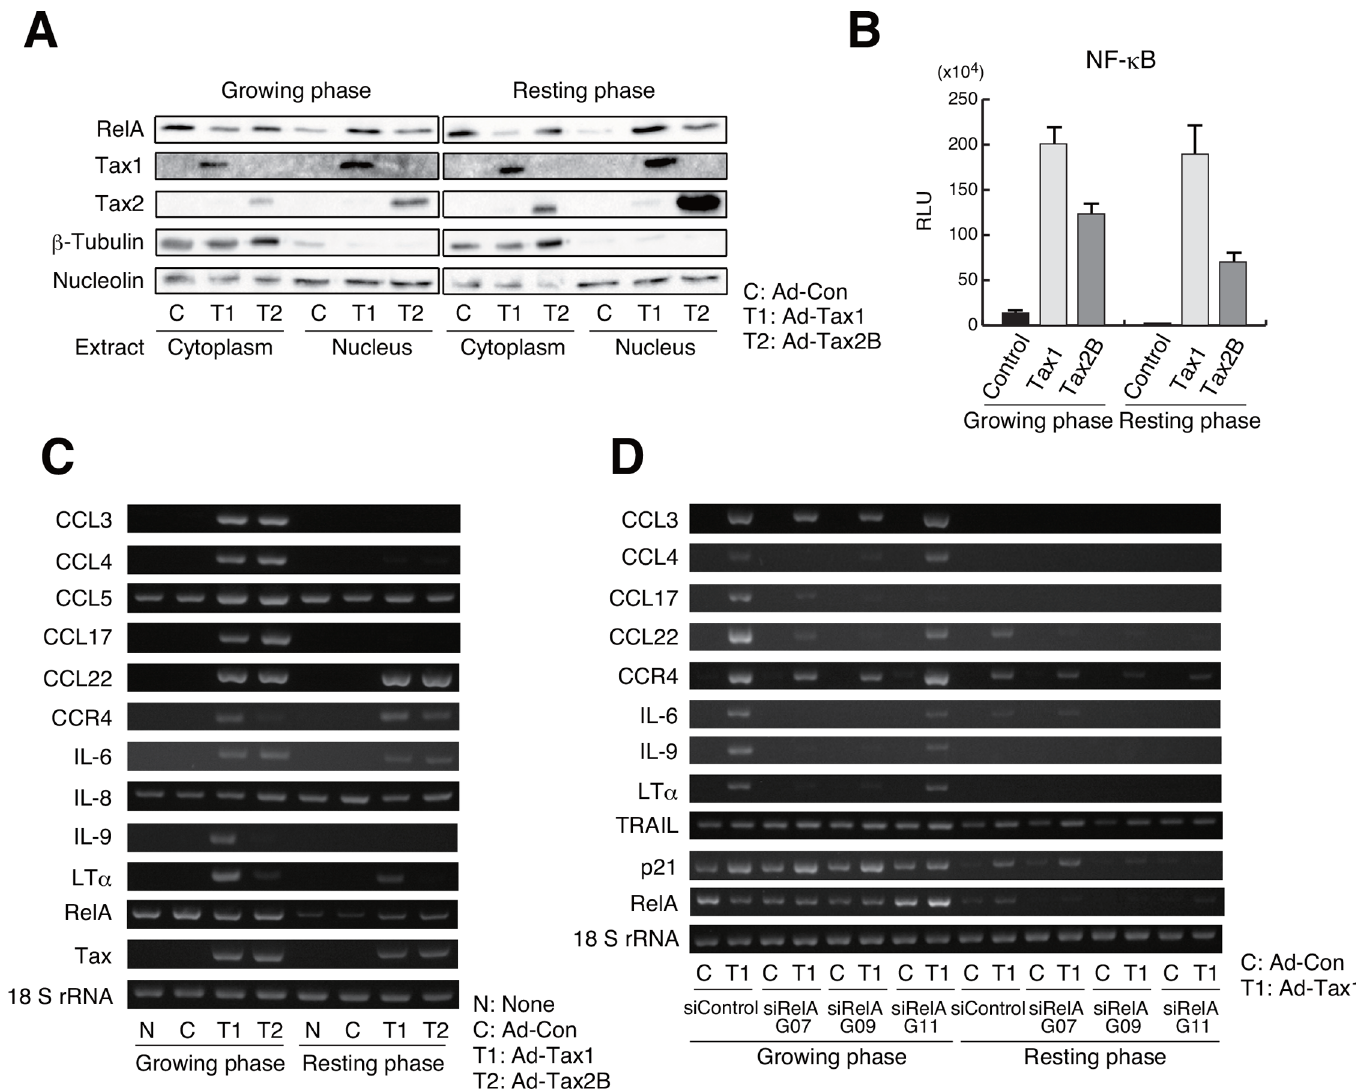
Fig 9. Induction of chemokines and cytokines by Tax1-mediated RelA activation. (A) Growing or resting Kit 225 cells were infected with Ad-Tax1 or Ad- Tax2B, and cultured for 72 h. The cytoplasmic and nuclear extracts were subjected to western blotting with antibodies for RelA, Tax1, Tax2, β -Tubulin and nucleolin. (B) The reporter plasmid carrying the NF- κ B-binding sites was transfected into Kit 225 cells along with the Tax1 and Tax2B expression plasmids (pMT-2Tax and pH β AP-r-1-neoTax2B, respectively). After 48 h of culture with or without IL-2, the cells were harvested for luciferase assay, which was further normalized against protein content. Values are shown as the means ± SE. (C and D) Growing or resting Kit 225 cells were infected with Ad-Tax1 or Ad- Tax2B, and cultured for 72 h (C). siRNA-treated growing and resting Kit 225 cells were infected with Ad-Con or Ad-Tax1, and cultured for 48 h (D). Gene expression was monitored by RT-PCR. 18 S rRNA was used as an internal